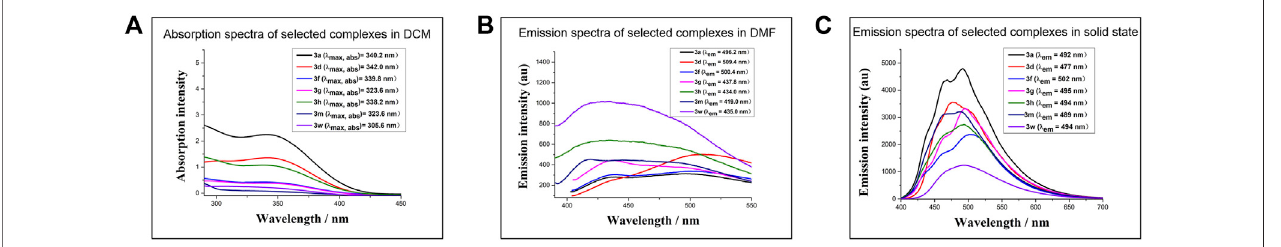
FIGURE 2 | The absorption and emission spectra of selected complexes.